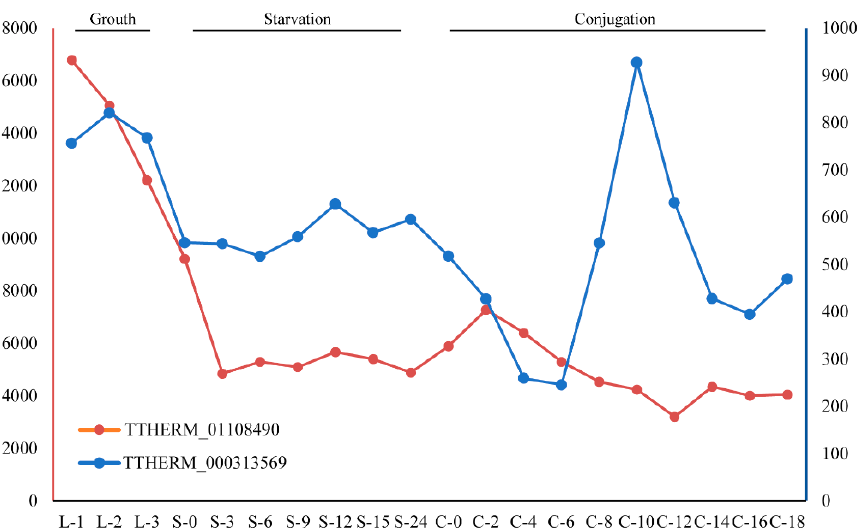
Figure 5. Expression levels of gene TTHERM_01108490 and TTHERM_000313569 at different stages of the life cycle in Tetrahymena thermophila.